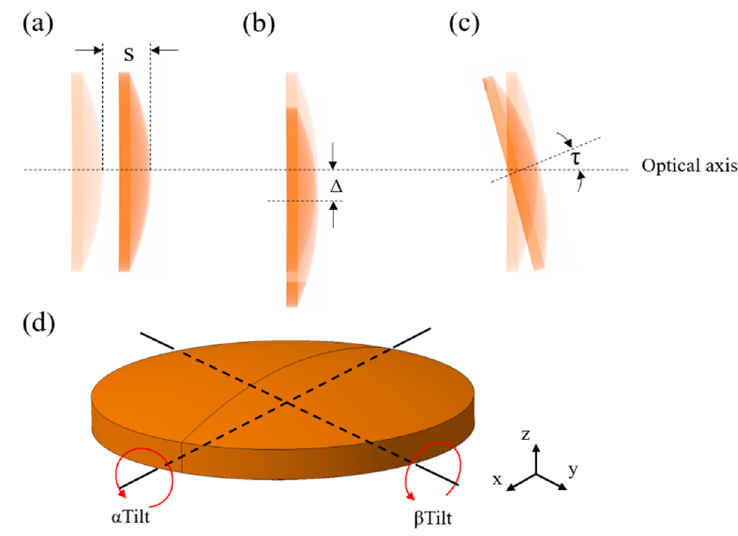
Figure 1. Undesired mis-alignments that occur at the secondary mirror; ( a ) De-space, ( b ) De-center, ( c ) Tilt, and ( d ) definition of α -Tilt and β -Tilt.